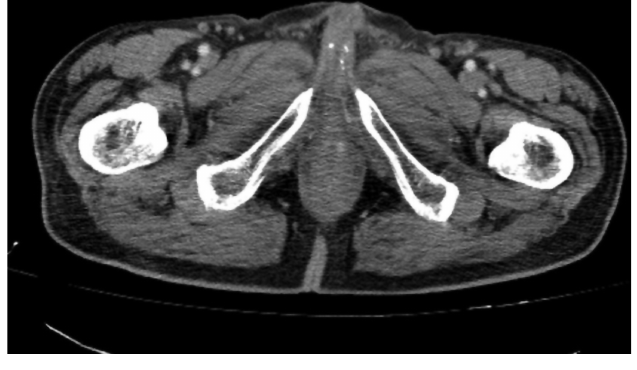
Table 2. The Characteristics and Frequency of